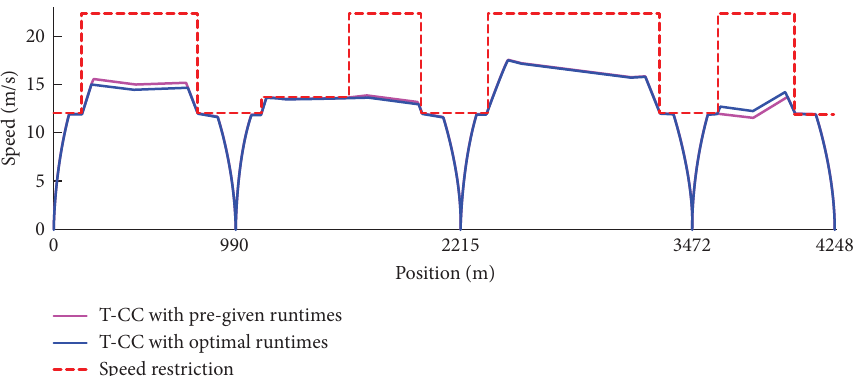
Figure 11: Te illustration of T-CC with optimal running times and T-CC with pre-given running times from S